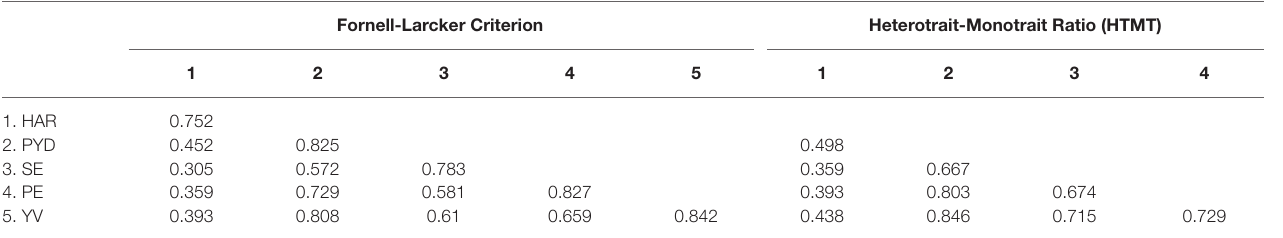
TABLE 2 | Measurement model: discriminant validity.